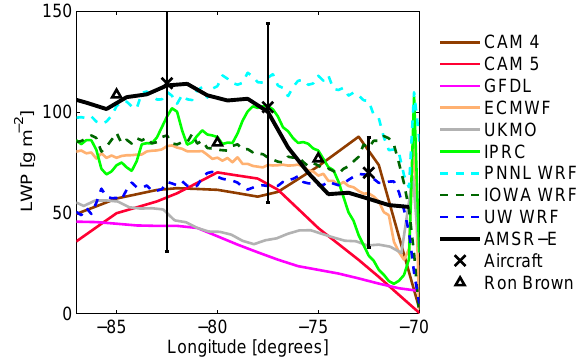
Figure 3. Grid-box mean LWP along 20 ◦ S compared with AMSR- E satellite mean of day and night passes and mean LWP from mi- crowave radiometer on the C-130 (Zuidema et al., 2012). Error bars represent interquartile ranges of aircraft leg means. Also plotted as triangles are mean values measured by the R/V Ron Brown from 2001 to 2008 (de Szoeke et al., 2012).